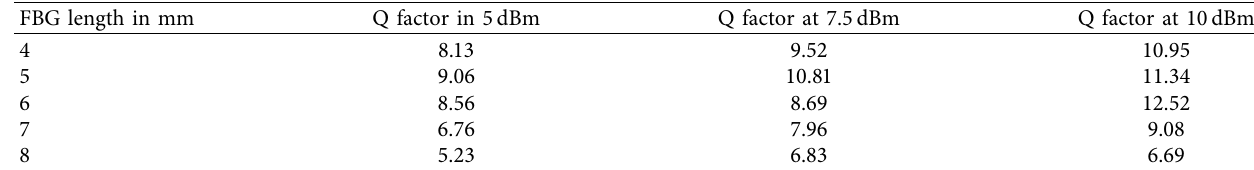
Table 5: Q-factor results for 4 FBG+DCF linear tanh apodization simulation models. FBG length in mm